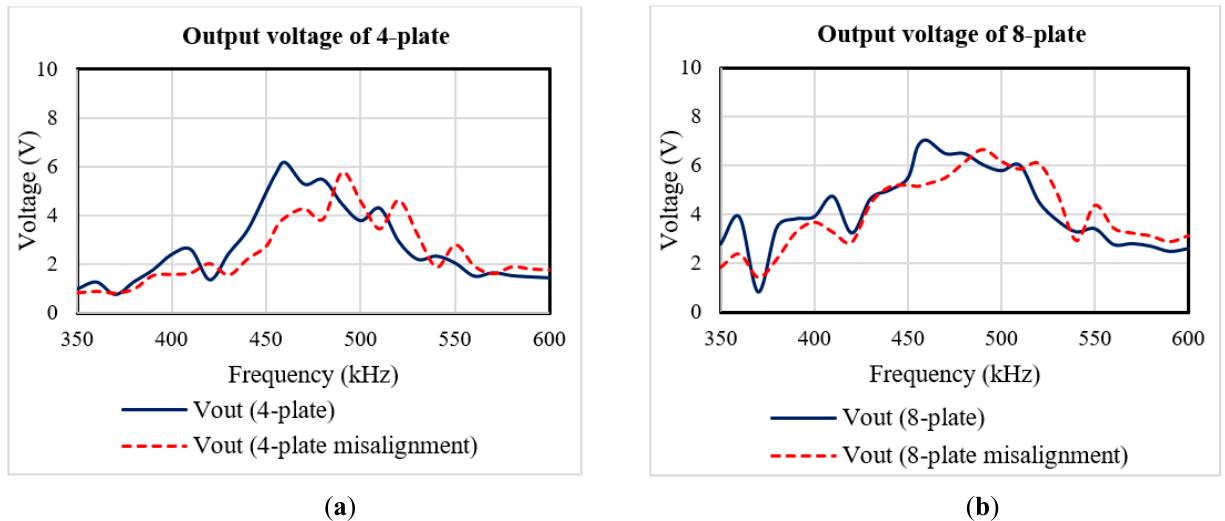
Figure 8. Output voltage of class-E 2 CPT with and without misalignments: ( a ) 4-plate coupling and ( b ) 8-plate coupling. ( b ) 8-plate